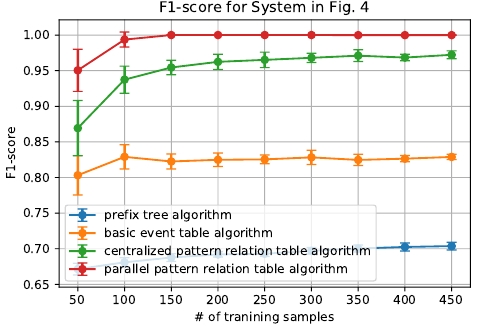
prefix tree algorithm basic event table algorithm centralized pattern relation table algorithm parallel pattern relation table algorithm